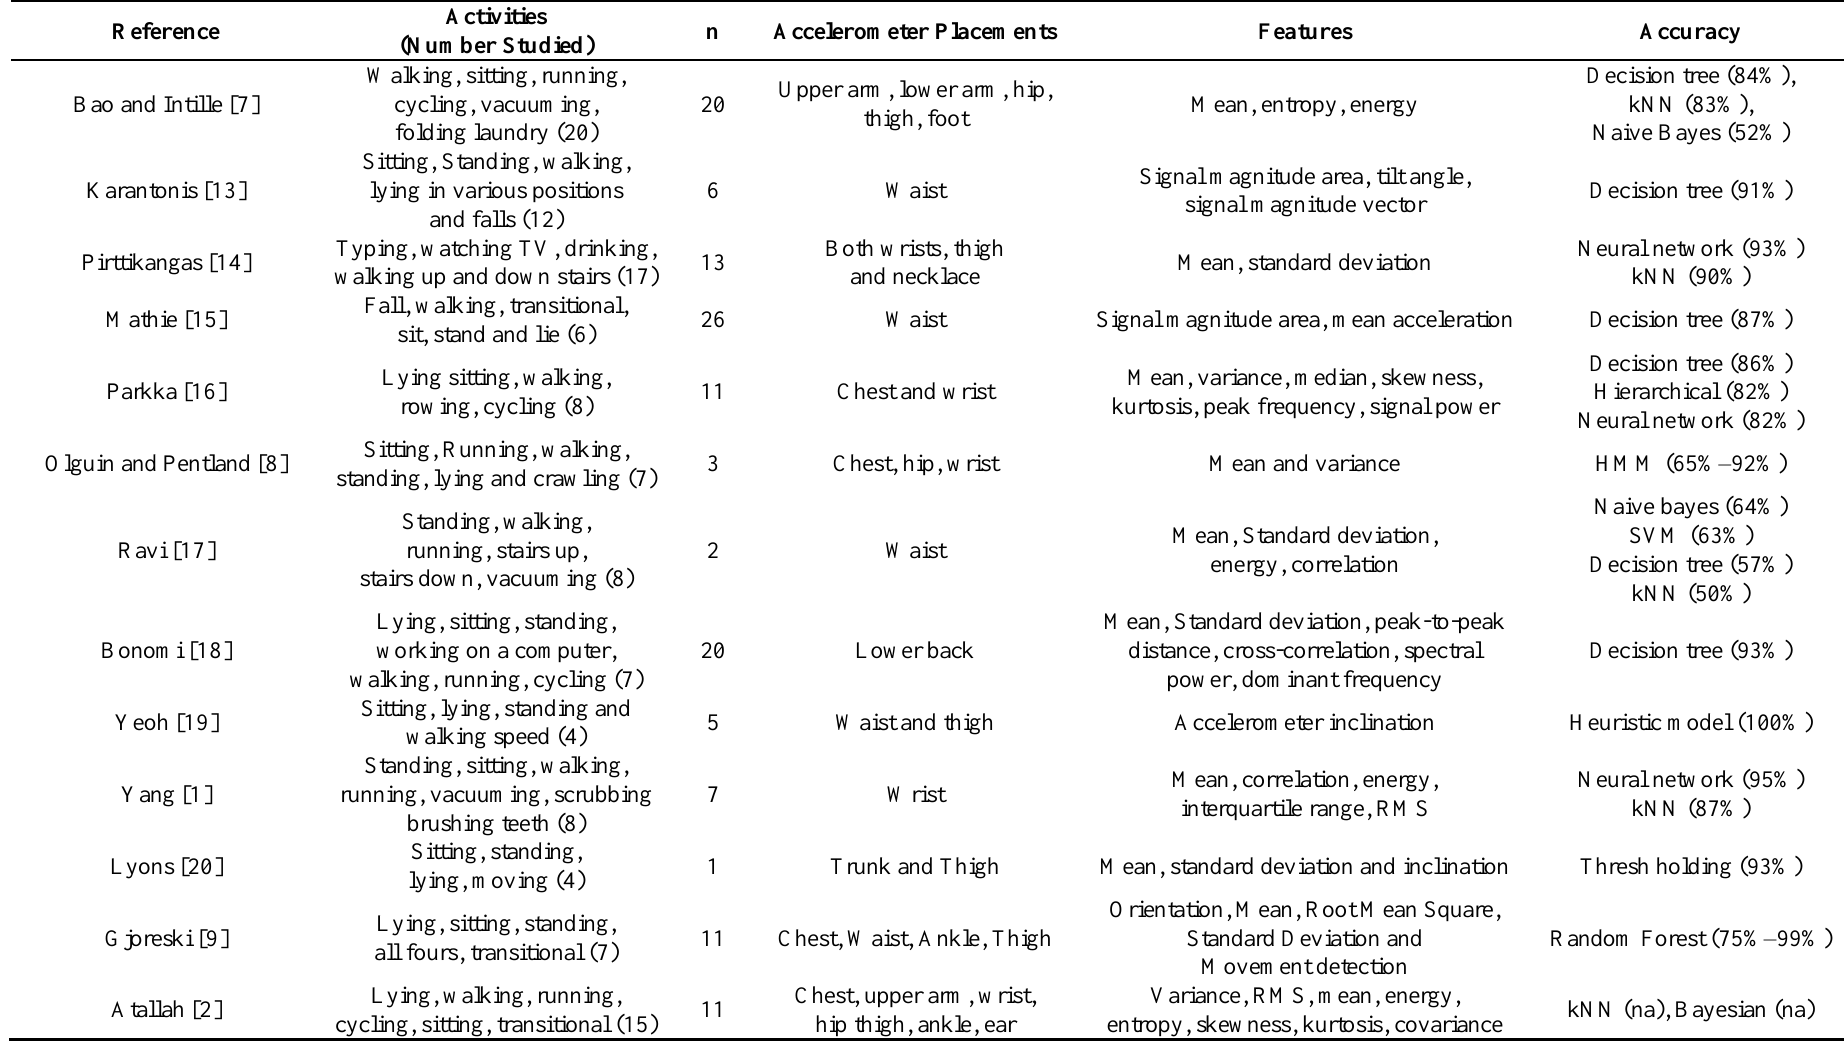
Table 1. Summary of notable works involving activity detection using accelerometry. The table includes the type of activities which were investigated (total number of activities is given in brackets), the number of subjects (n), the features used and detection accuracy